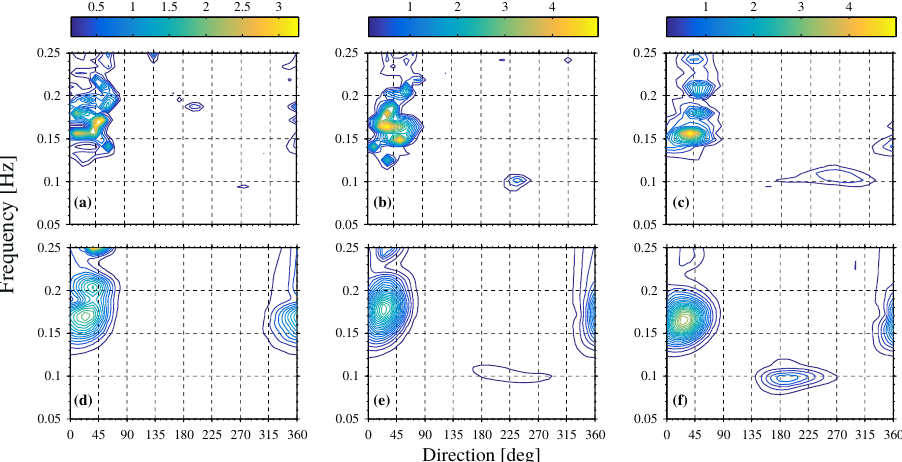
Figure 9. As in Figure 5, but for 26 October 2012 at 0100 UTC.